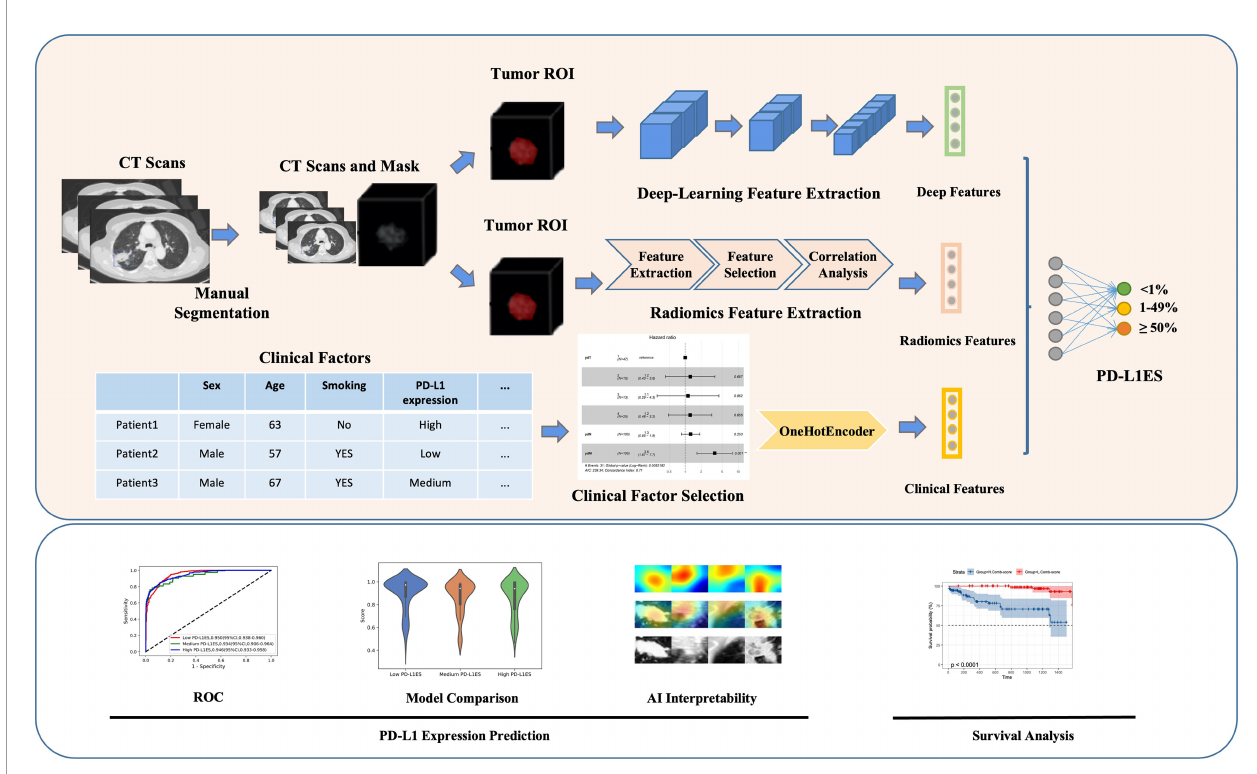
FIGURE 1 | Overall work fl ow of study design. The upper part showed the overall method of the study, while the lower part represented the analysis of the model. Original CT imaging data with manually labeled tumor images, comprehensive patient clinical information, overall survival, and PD-L1 expression signature were included in the data processing step. The deep learning, radiomics and clinical features were retrieved using the tumor ROI or clinical records during the feature extraction step. All features were utilized to predict PD-L1 expression signature and evaluate patient survival. PD-L1ES, PD-L1 expression signature; ROI, region of